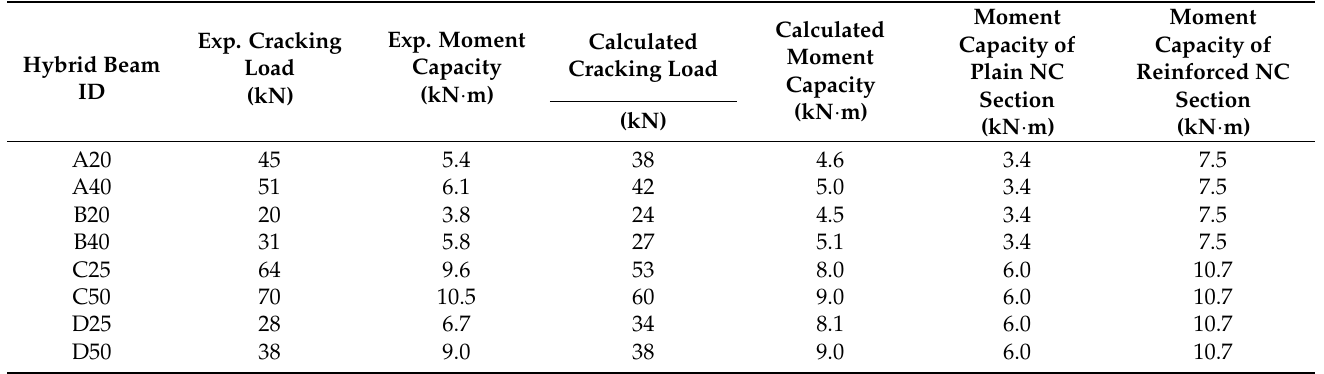
Table 10. Moment capacity of hybrid, plain NC, and reinforced NC sections.